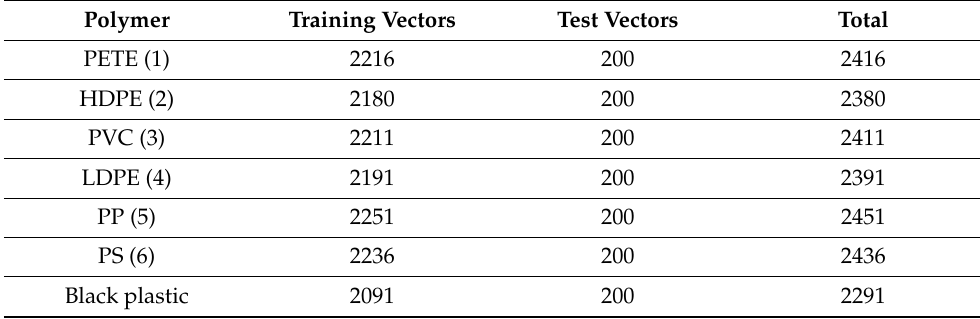
Table 5. Number of vectors per data class for HDR and non-HDR datasets (case